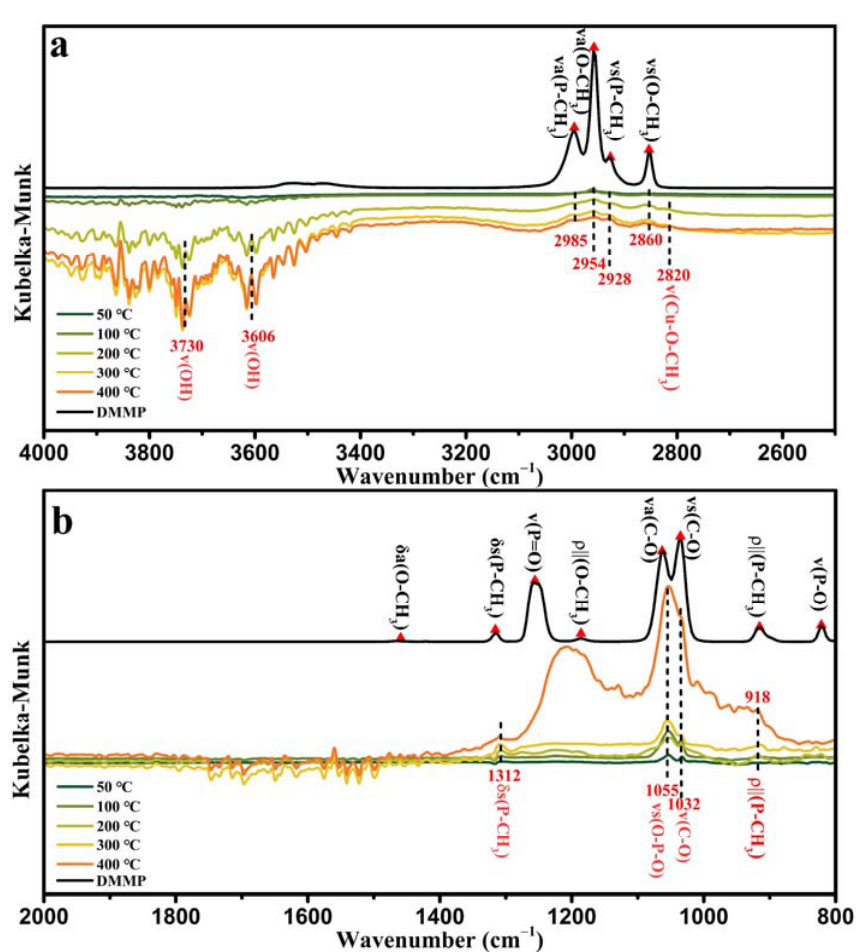
Figure 15. In situ DRIFTS spectra of CuO at varying temperatures in ( a ) the high ‐ frequency region and ( b ) in the mid–low frequency